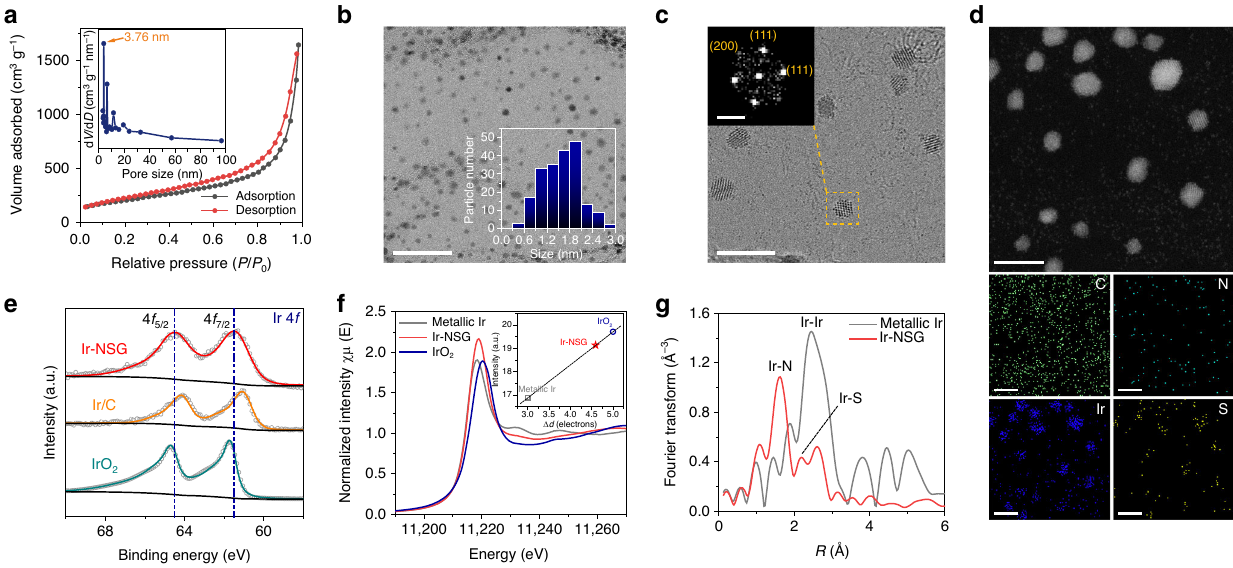
Fig. 1 Structural characterization of Ir nanoclusters dispersed on N,S-doped graphene. a Nitrogen adsorption isotherm of Ir-NSG measured at 77 K. The inset shows the corresponding BJH pore size distribution curve. b Bright- fi eld TEM image (inset shows the corresponding particle size distribution of Ir nanoclusters based on a count of 200 in the sample area), scale bar: 20 nm. c Bright- fi eld HRSTEM image and the corresponding FFT of the selected area in the yellow square (inset), scale bars: 5 nm and 5 nm − 1 for the TEM and FFT pattern, respectively. d Dark- fi eld STEM image and EDX elemental mappings, scale bars: 5 nm. e High-resolution XPS Ir 4 f spectra. f Ir L 3 -edge XANES spectrum of Ir-NSG with reference metallic Ir and IrO 2 (inset shows the integrated while line (WL) intensity as a function of 5 d -band holes ( Δ d ), which is calibrated from metallic Ir (5 d 7 ) and IrO 2 (5 d 5 ) standards). g Fourier transformation of the EXAFS spectra of Ir-NSG and metallic